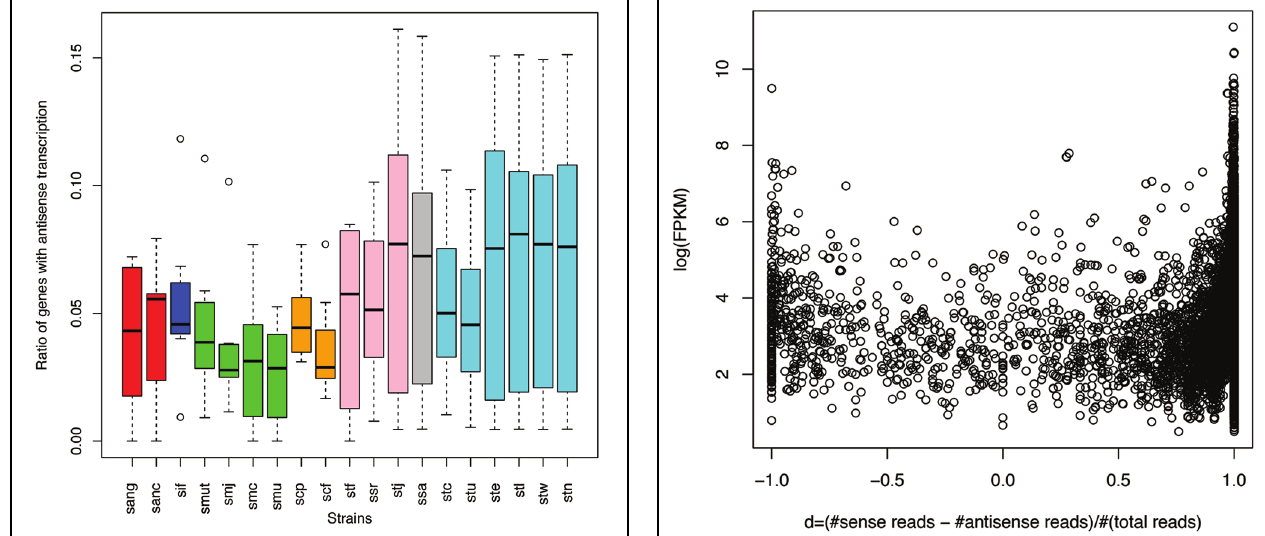
FIGURE 7 | Highly expressed genes tend to be dominated by sense transcription or antisense transcription. Each circle represents a gene. The y-axis shows the gene expression ( log (FPKM)) and the x-axis shows d, which is close to 1 for genes with mostly sense transcription, and − 1 with mostly antisense transcription. RNA-seq data from individual 1 (X310763260) was used for this plot. To limit the bias that may be introduced by rare species or genes with low expression levels, we only included the genes (3,689 in total) each supported by at least 20 RNA-seq reads, and are from the species (23 in total) each having at least 100 genes with RNA-seq reads support. See Supplementary Figure S2 for the plot using the original gene expression data, involving 30,493 genes from all 47 strains, one for each